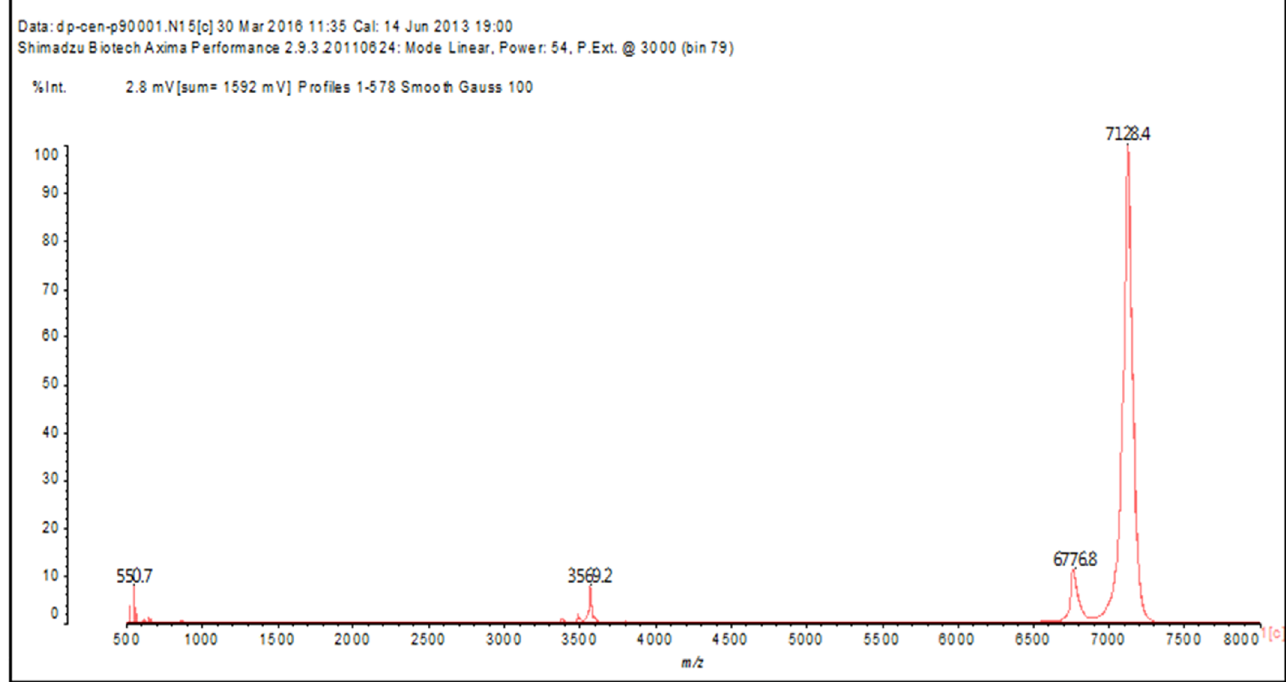
Figure 2. MALDI-TOF spectra (m/z) of the content present in the sample DPKEN9.